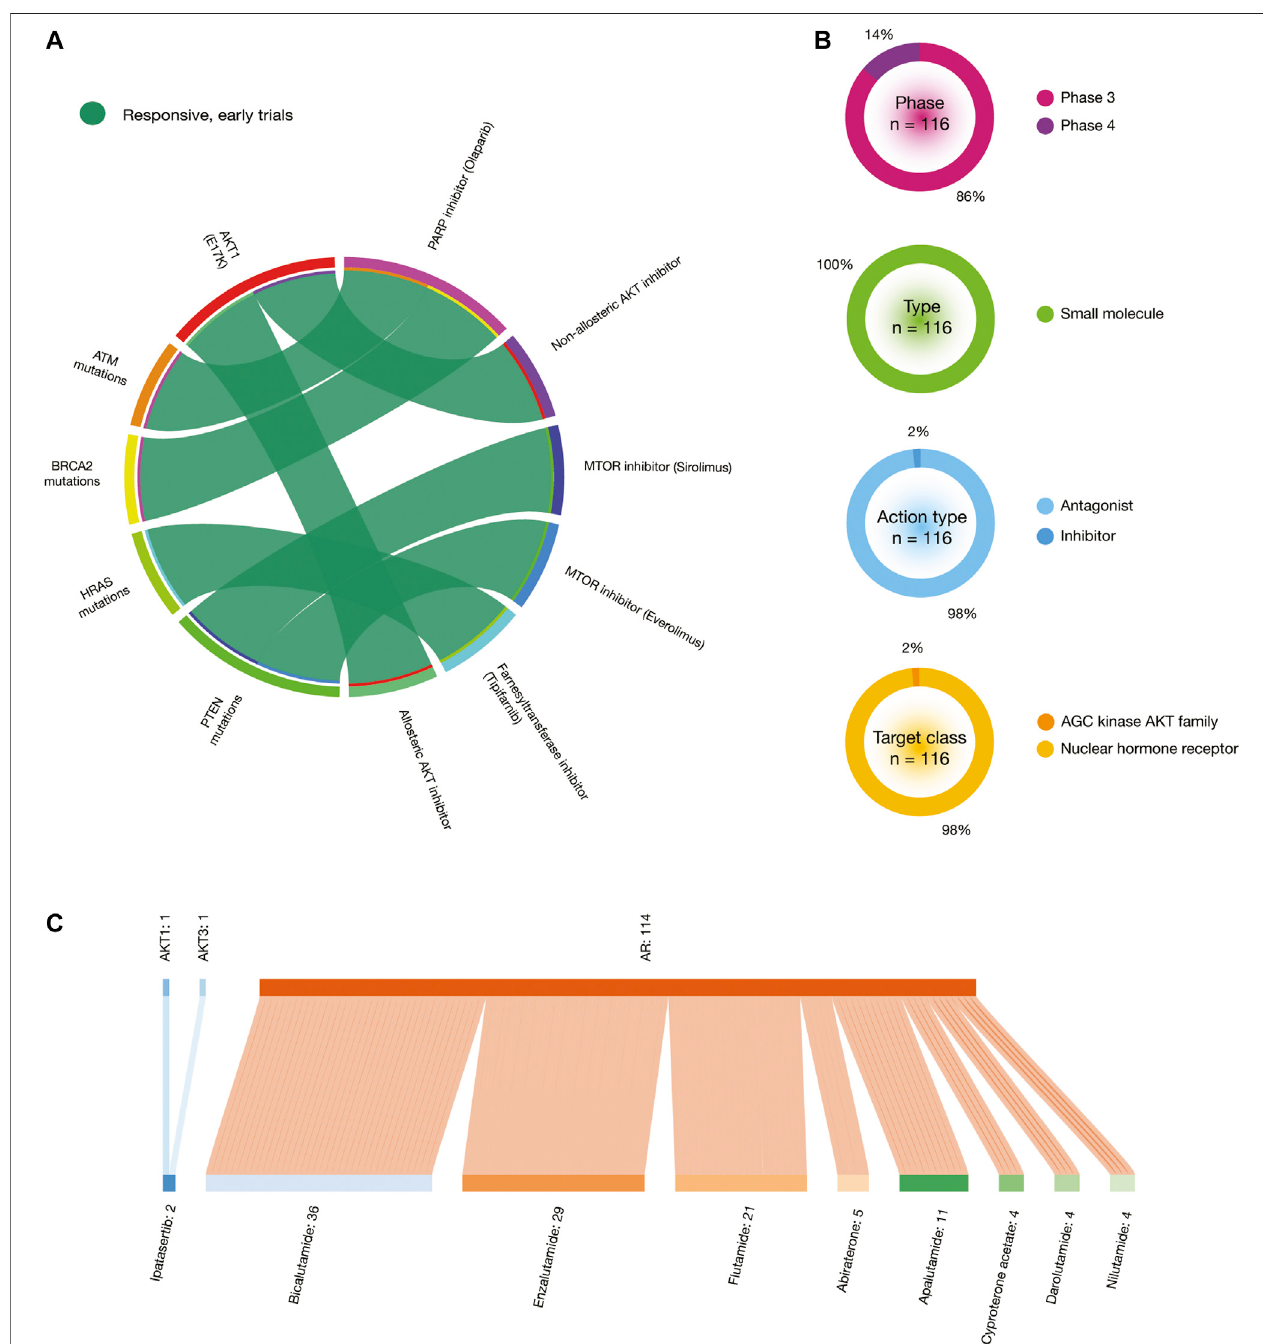
FIGURE 9| In silico drug prescriptions and clinical trials involved in PRCA. (A) Circos plot showing precision medicine application between drugs and PRCAdriver mutations. (B) Clinical trial features on PRCA. (C) Sankey plots of drugs with the highest number of clinical trials on PRCA driver proteins.